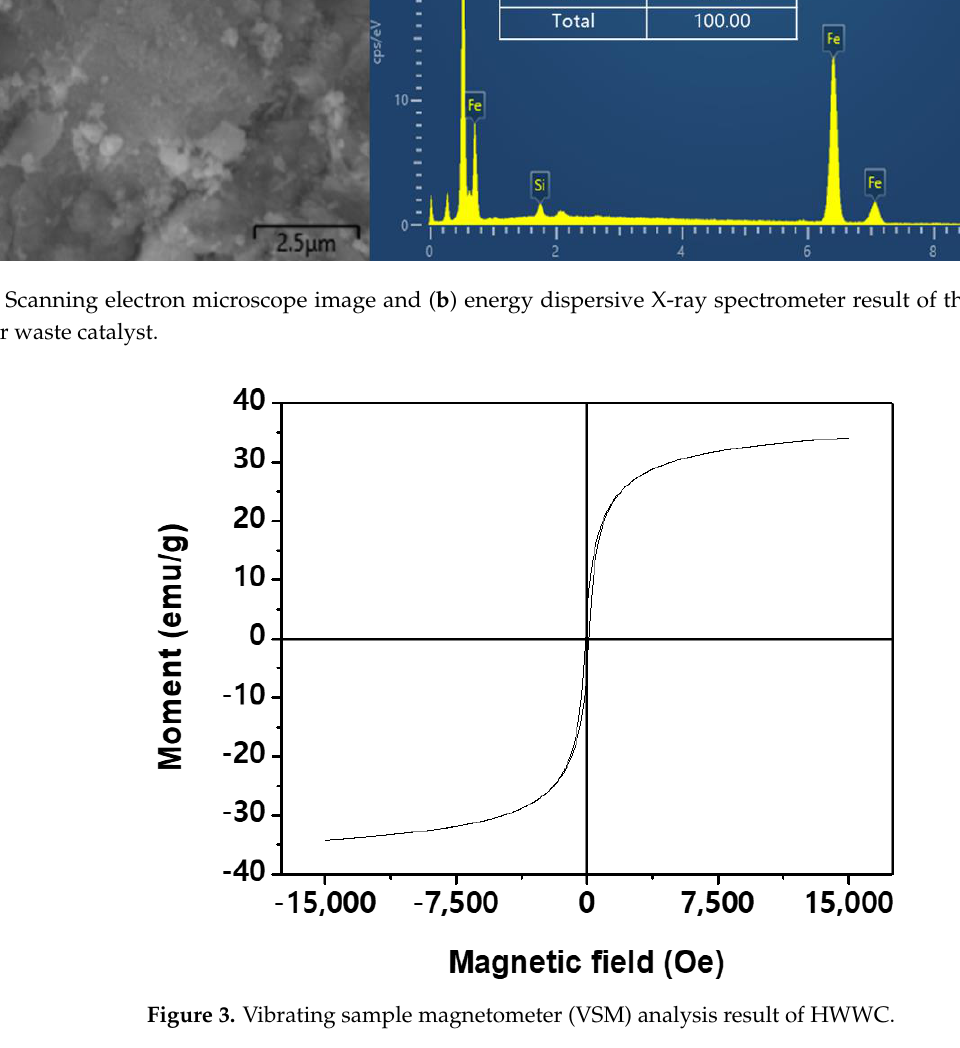
Figure 2. ( a ) Scanning electron microscope image and ( b ) energy dispersive X-ray spectrometer result of the prepared hand-warmer waste catalyst.